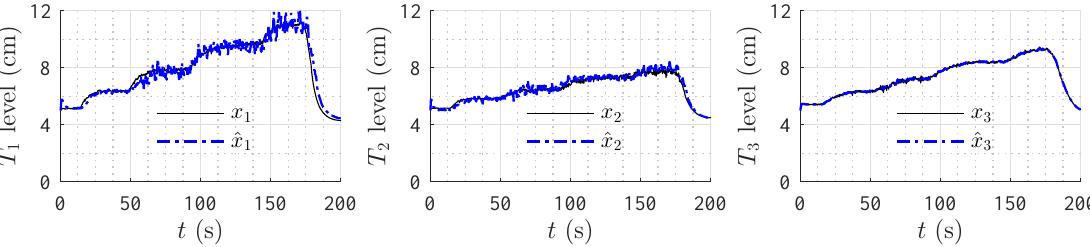
Figure 10. HGO experimental results: v-notch weir at T 2 and circular weir at T 3 , k = [ 0.8,0.17,0.01 ] T .